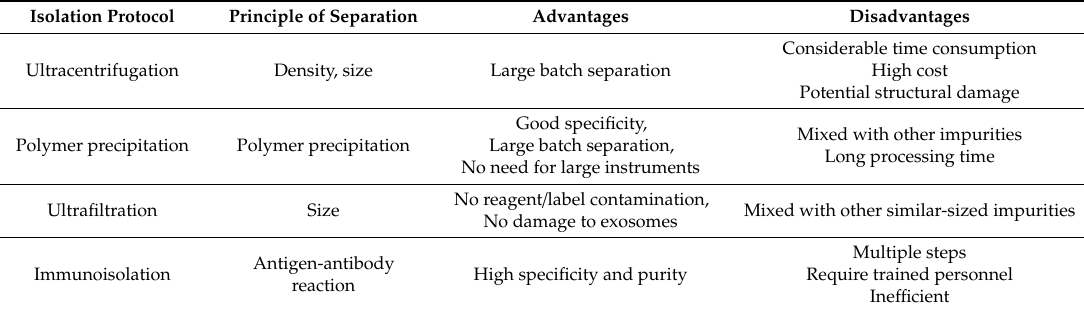
Table 1. Comparison of traditional exosomes isolation